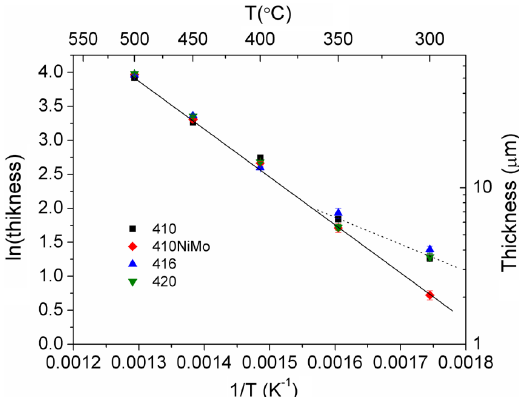
Figure 4. Arrhenius plot for the nitrided layer thickness for all studied steels and temperatures. Treatments carried out for 4 h, using a gas mixture composition of 70% N flow rate of 3.33×10 6 Nm 3 s −1 and pressure of 3